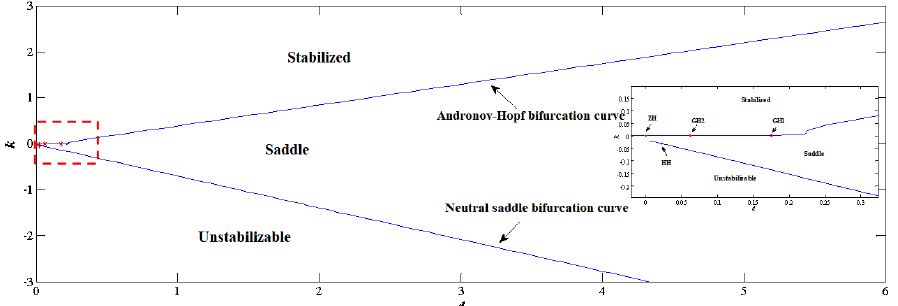
Figure 6. Two − parameter continuation diagram for the control variables, where GH1 and GH1 are the general Hopf bifurcation, ZH is the zero Hopf bifurcation and HH is the Hopf–Hopf